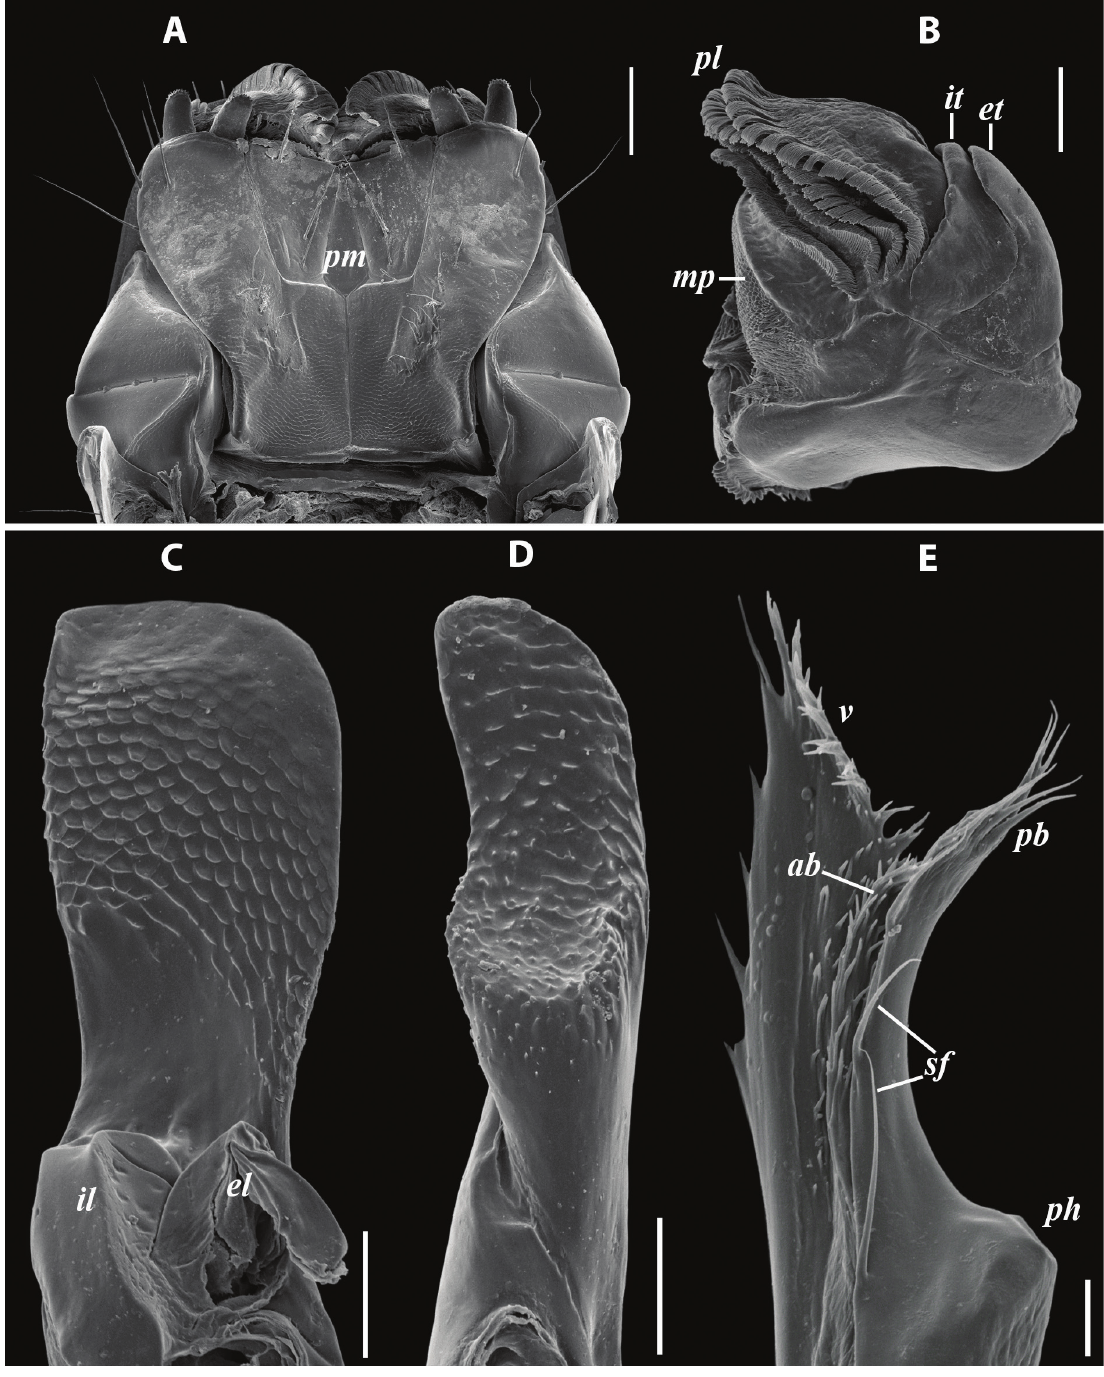
Fig. 2. Stygiiulus fimbriatus (Strasser, 1971) comb. et stat. nov., ♂ from from Foran di Landri Cave (IBER). A . Gnathochilarium, ventral view. B . Gnathal lobe of left mandible, ventral view. C . Left promere, caudal view. D . Left mesomere, oral view. E . Distal part of left opisthomere, mesal view. Abbreviations: ab = anterior branch of solenomere; el = external lobe; et = external tooth; il = internal lobe; it = internal tooth; mp = mollar plate; pb = posterior branch of solenomere; ph = posterior hump; pl = pectinate lamellae; pm = promentum; sf = setiform filaments; v = velum. Scale bars: A = 0.2 mm; B = 0.1 mm; C–D = 0.05 mm; E = 0.02